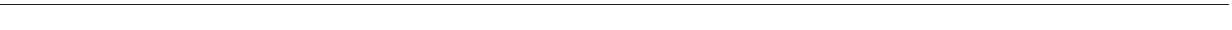
Fig. 5 Safety evaluation of PQ-loaded vesicles in mouse model. a Body-weight changes of 6-week-old female C57BL/6 mice that were intraperitoneally administered saline as a control group and a single-dose of PQ or PQ-loaded vesicles at 20 mg kg − 1 dosage on the fi rst day ( n = 6 in each group). b Survival curve of 6-week-old female C57BL/6 mice that were intraperitoneally administered a single dose of saline, or PQ and PQ-loaded vesicles at 40 mg kg − 1 dosage on the fi rst day ( n = 6 in each group). c Quantitative analysis of liver function biomarkers (ALT and AST), and d renal function biomarkers (UA and BUN), analyzed in the blood of the mice intraperitoneally administrated with PQ and PQ-loaded vesicles at a dose of 30 mg kg − 1 . The blood samples were collected on day 3 and day 31 after dose administration, respectively. e Quantitative analysis of DA and DOPAC in the striatum of the mice to evaluate potential PD development, and f quantitative analysis of in fl ammatory factors (IL-1 β , TNF- α , IL-6, and IL-10) in the lungs of the mice. The organ tissues were collected on day 3 and day 31 after dose administration, respectively. The error bars correspond to the SD ( n = 3). * P ≤ 0.05, ** P ≤ 0.01 and *** P ≤ 0.001 determined by two-way ANOVA followed by Tukey ’ s test. g H&E staining of the liver, lungs, kidneys, striatum, and nigra and h Masson ’ s trichrome staining of the lungs, in the mice after intraperitoneal administration of PQ and PQ-loaded vesicles at 30 mg kg − 1 dosage. The organ